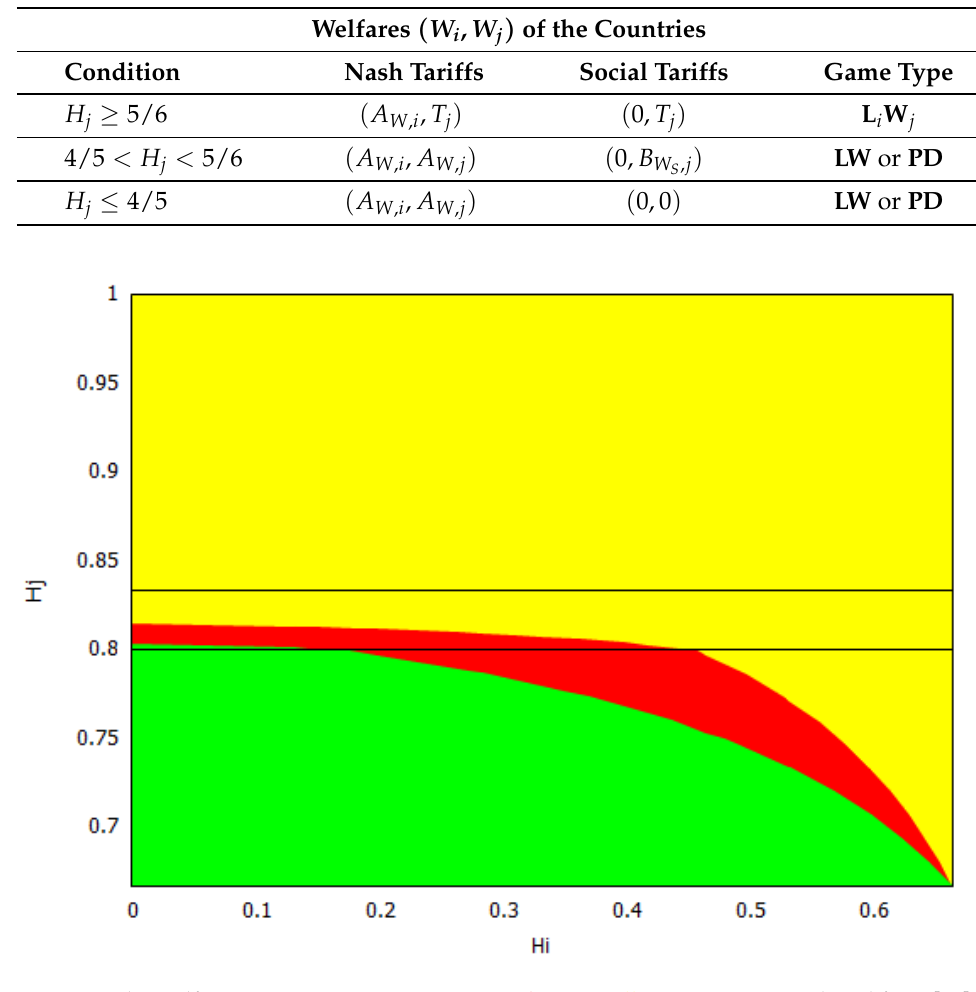
Figure 1. The welfare game type: Green— L j W i ; Red— PD ; Yellow— L i W j . Reproduced from